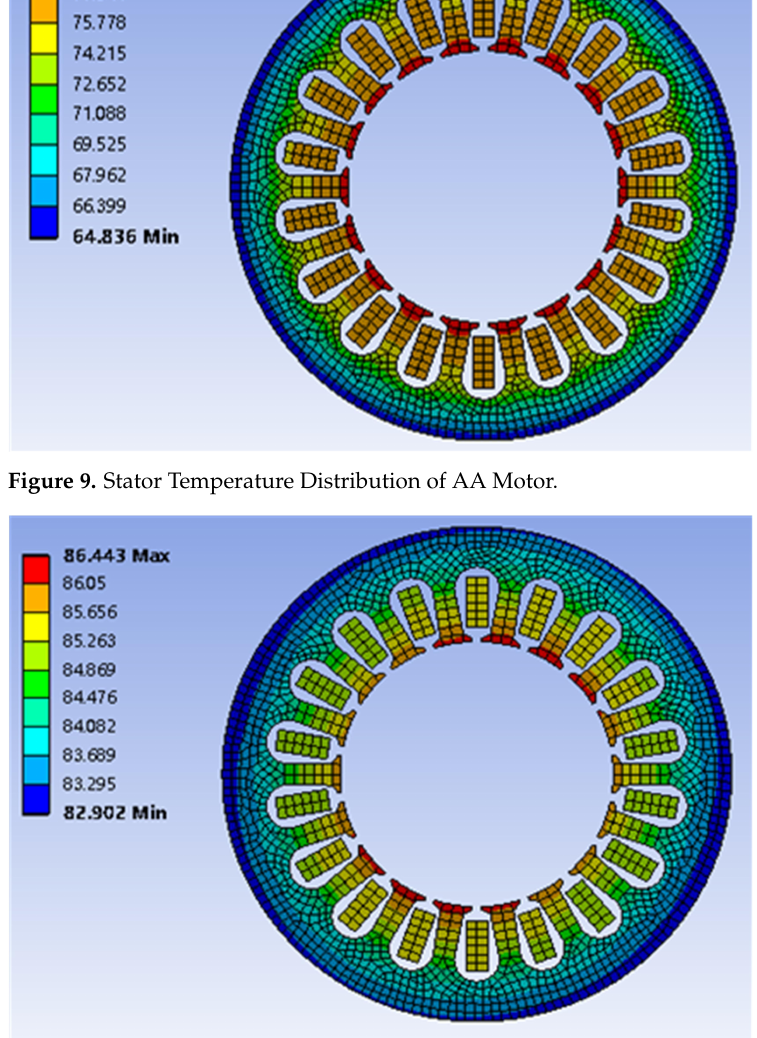
Figure 10. Stator Temperature Distribution of the Silicon Steel